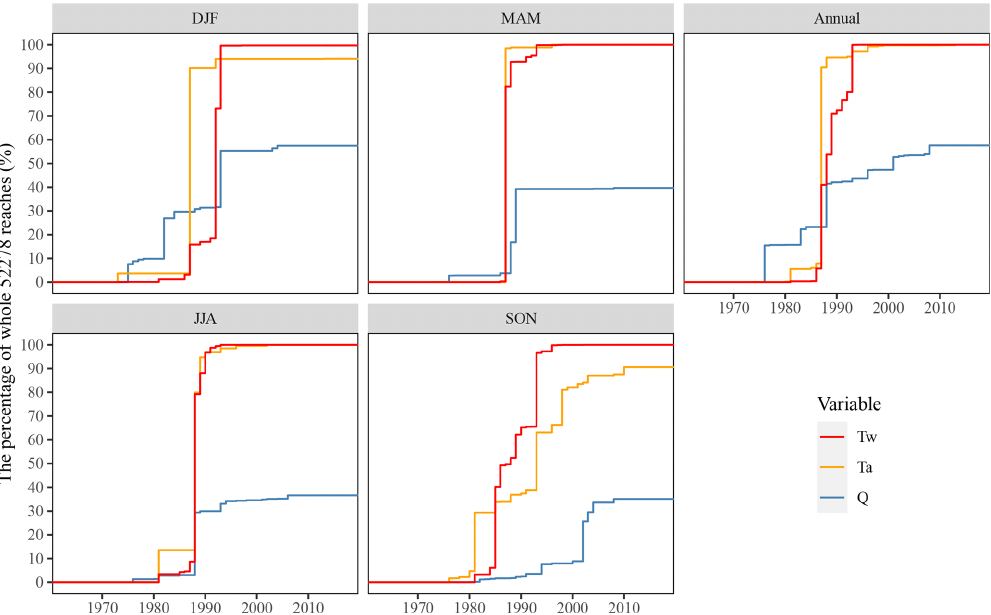
Figure 7. Change points in T w , T a , and Q time series at the seasonal and annual scales, plotted as a proportion of reaches experiencing a shift in a given year. Only the first change point detected at the 95% confidence level is considered, and non-significant change points were removed, leading to curves not reaching